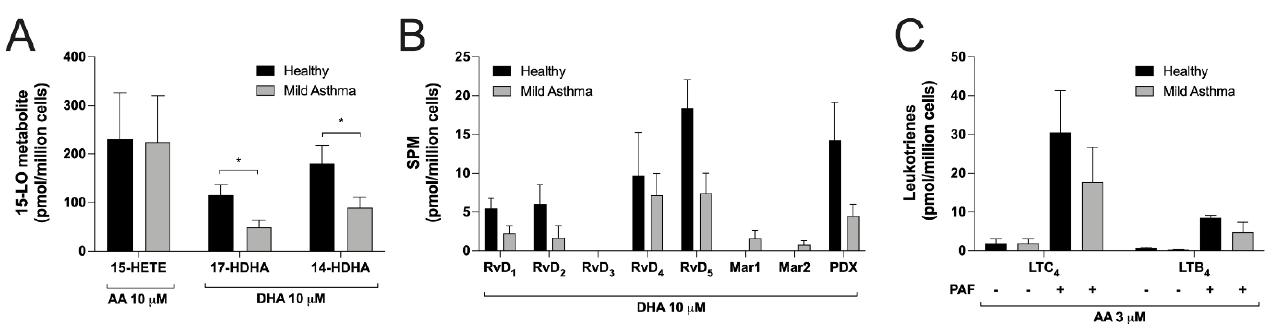
Figure 6. Comparison between eosinophils from healthy and asthmatic donors. EOS suspensions (5 × 10 6 cells/mL, 37 ◦ C) were treated with ( A ) 10 µ M AA or DHA, ( B ) 10 µ M DHA or ( C ) the combination of 1 µ M PAF and 3 µ M AA for 15 min. Incubations were stopped by adding one volume of cold ( − 20 ◦ C) MeOH containing the internal standards. Samples were processed and analyzed for eicosanoids and docosanoids content by LC-MS/MS, as described in Materials and Methods. Results are the mean ( ± SEM) of 5 independent experiments using human eosinophils from asthmatic donors and 5 independent experiments using human eosinophils from healthy donors. Data from asthmatic donors are the same as those presented in Figures 1, 3 and 5. p -values were obtained as described in Materials and Methods. * p < 0.05.